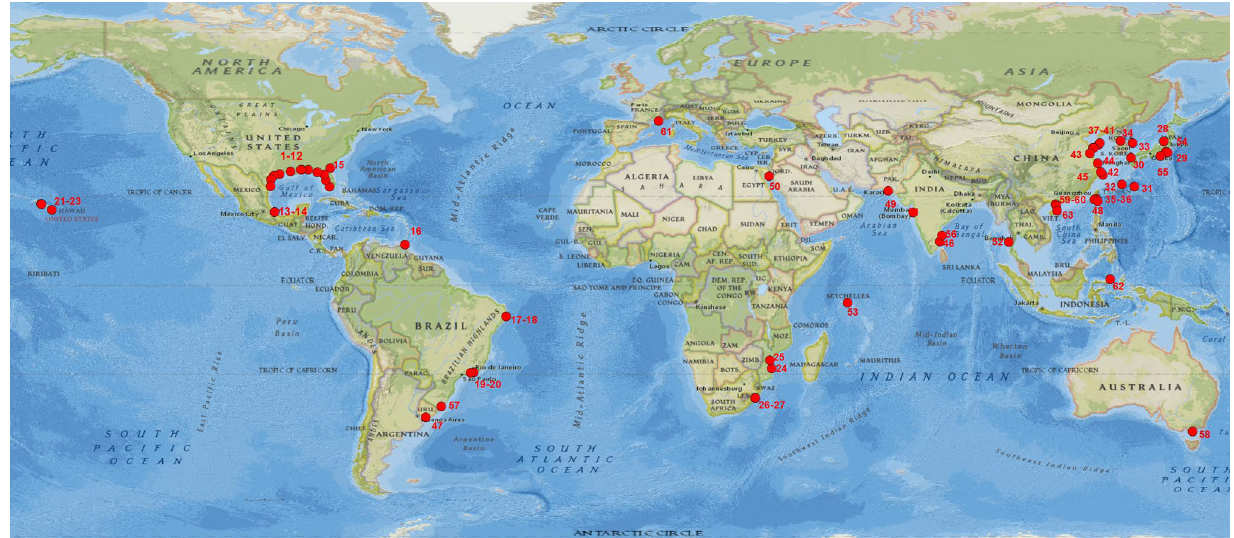
Figure 7. Currently documented global distribution of L. exotica (red dots). Mainly adapted from Hurtado et al., 2018. Map source: National Geographic World Map (ESRI). Downloaded from ArcGIS online, 2019. Sample locations were generated with software ArcGIS, desktop standard for business (https:// www. esri. com/ en- us/ arcgis/ produ cts/ arcgis- deskt op/ overv iew). Version 10.5, Esri, USA, from excel based on